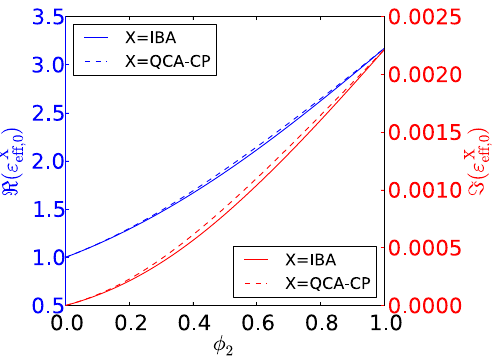
Figure 2. Real and imaginary parts of dielectric constant ε IBA ε QCA-CP in the very low frequency limit as a function of ice volume eff,0 fraction φ 2